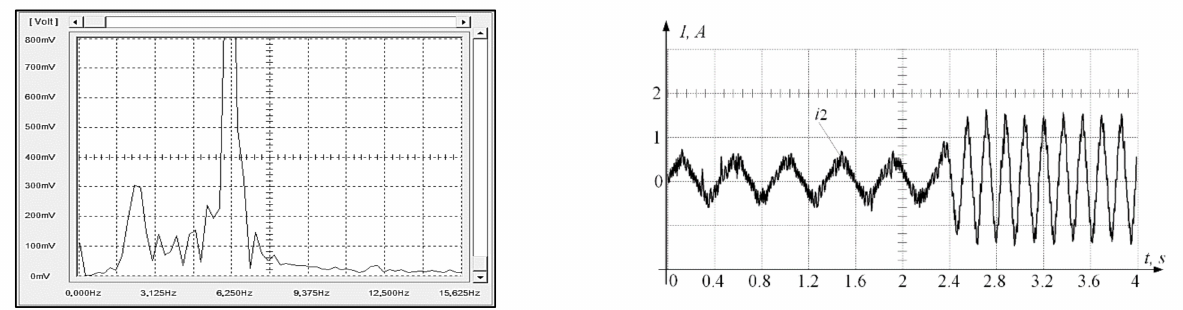
Figure 11. Rotor currents and current spectrum in a scalar controlled drive.